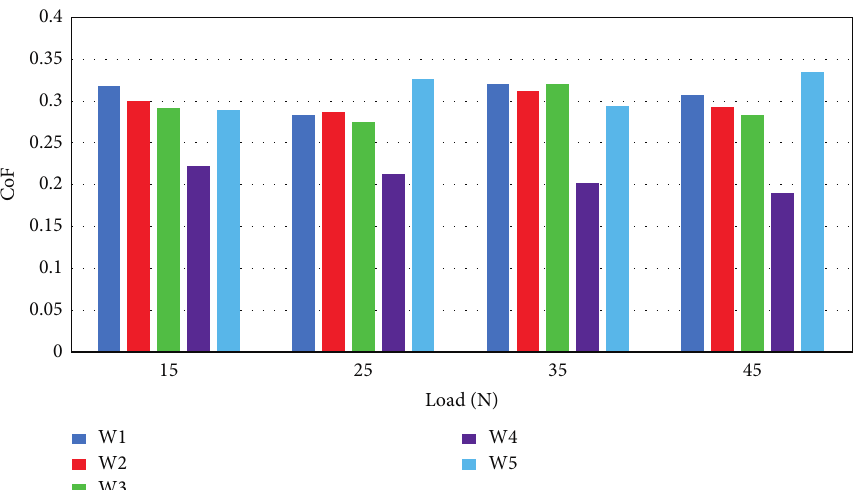
Figure 9: Variation on the coefficient of friction (CoF) of composites for 750m sliding